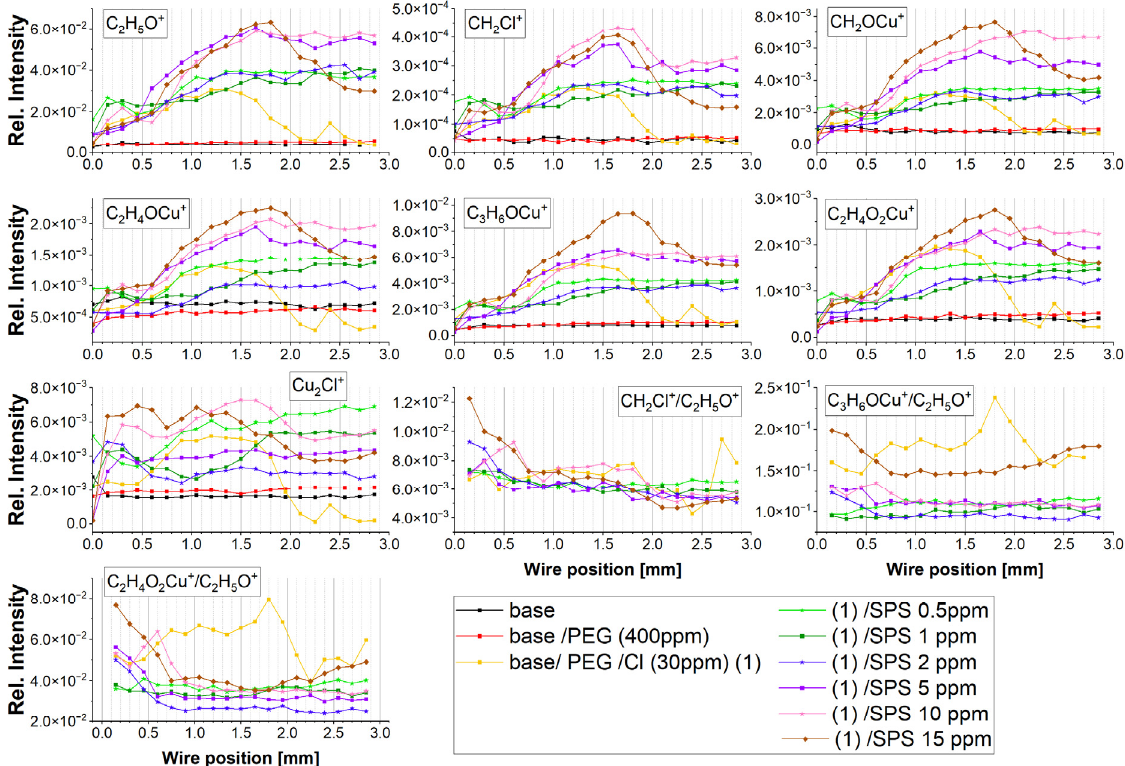
Figure 3. Distribution of intensity of the fragments: C 2 H 5 O + , CH 2 Cl + , CH 2 OCu + , C 2 H 4 OCu+, C 3 H 6 OCu + , C 2 H 4 O 2 Cu + , Cu 2 Cl + , the ratio of CH 2 Cl + /C 2 H 5 O + , C 3 H 6 OCu + /C 2 H 5 O + , and C 2 H 4 O 2 Cu + /C 2 H 5 O + along the wire position for the base electrolyte, base/PEG, base/PEG/Cl, and base/PEG/Cl/SPS at concentrations of 0.5, 1, 2, 5, 10, and 15 ppm. The wire position corresponds to the applied overpotential during the CV experiment.